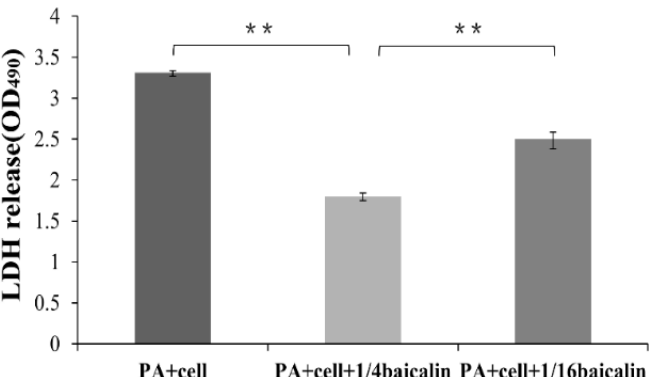
Figure 3. Inhibition of cytotoxicity of P. aeruginosa PAO1 to eukaryotic cells by baicalin. 1/4 and 1/16 represent 250 µ g/mL and 62.5 µ g/mL of baicalin respectively; Averages of triplicate exper- iments ± standard errors of the means are shown. The results shown are representative of three independent experiments with similar trends. ** very significant difference ( p < 0.01).